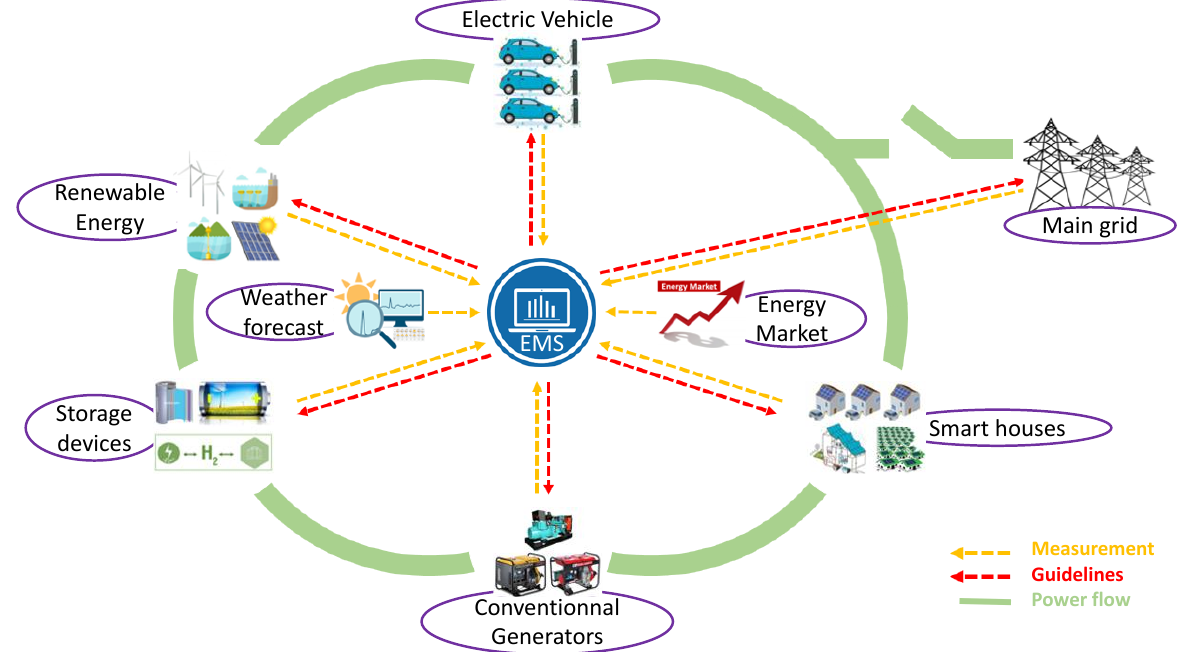
Figure 2. Microgrid